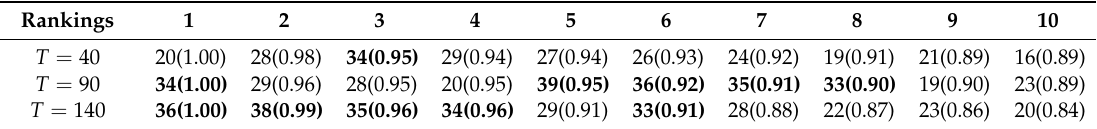
Figure 7. Dynamic critical nodes and regions identification results for case C. ( a ) The critical nodes; ( b ) the critical regions. Table 3. Top 10 critical nodes with their importance score in case C.